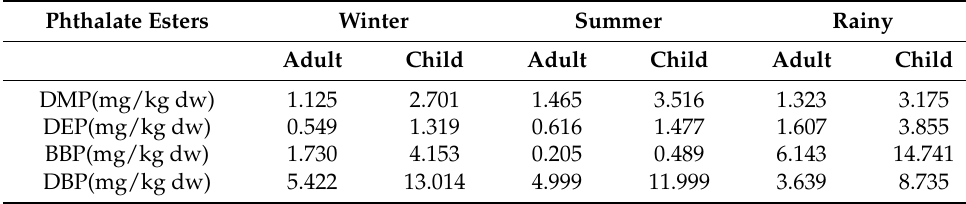
Table 2. Adult and child exposure of phthalates in water samples of Harike wetland.